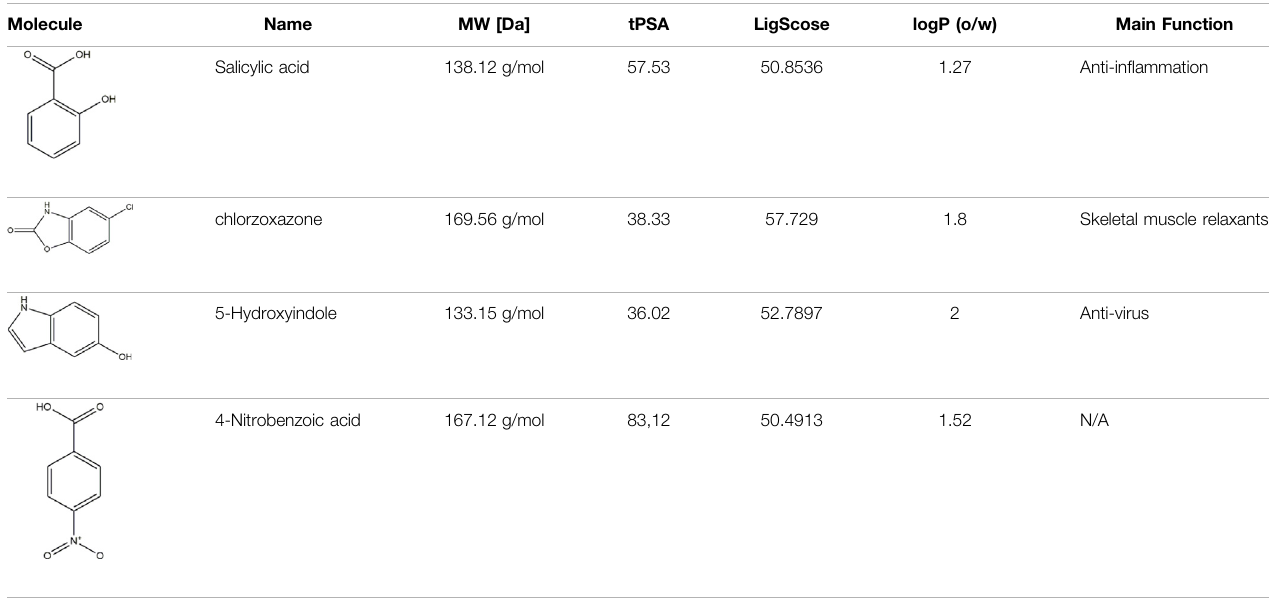
TABLE 1 | Detailed information of the fi nal fragments after screening